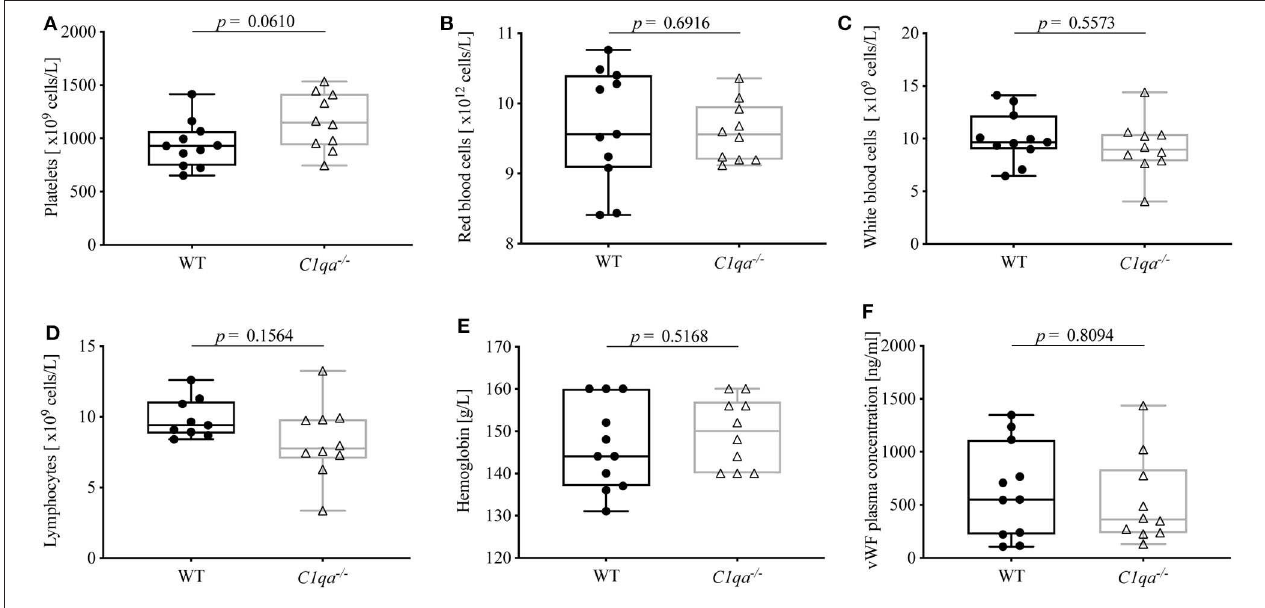
FIGURE 1 | Complete blood counts and vWF levels of C1q-deficient vs. WT mice. EDTA-anticoagulated whole blood of C1q-deficient and WT mice was obtained and quantified by flow cytometry for numbers of (A) platelets, (B) red blood cells, (C) white blood cells, (D) lymphocytes, and (E) amount of hemoglobin. (F) From citrated blood, vWF plasma concentration was quantified using ELISA. Horizontal lines in the box plots denote median while the boxes indicate interquartile range and whiskers minimum and maximum values. Data points represent individual mice, (A–F) : n = 11, △ : n = 10; (D) : n = 9, △ : n = 10 (Mann–Whitney test; ns, not significant).